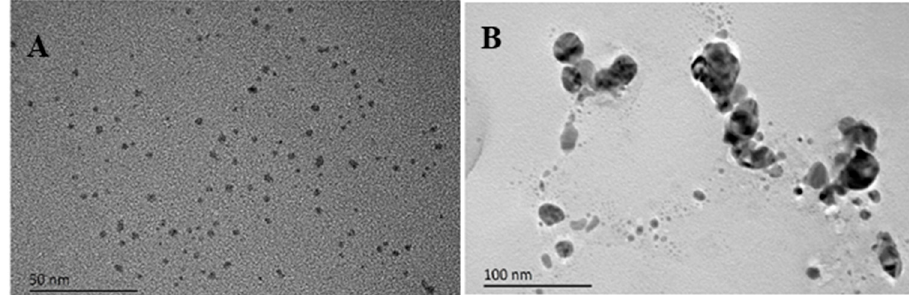
Figure 6. TEM images of MMI-CuNCs in the absence ( A ) and presence ( B ) of Ag + [53], Copyrights from American Chemistry Society, 2022.